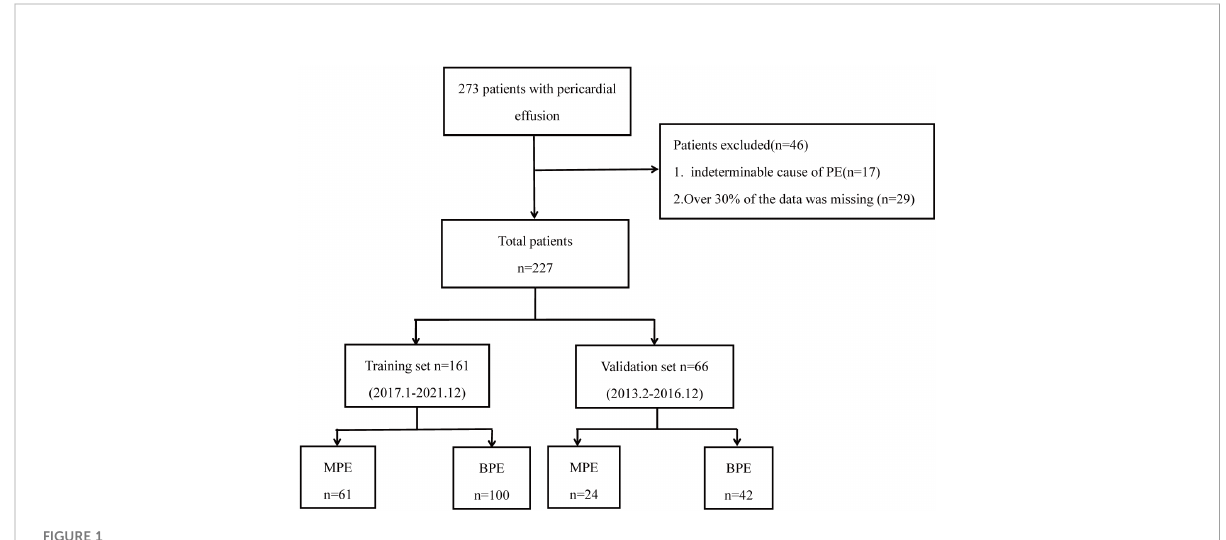
FIGURE 1 Flow chart of participant